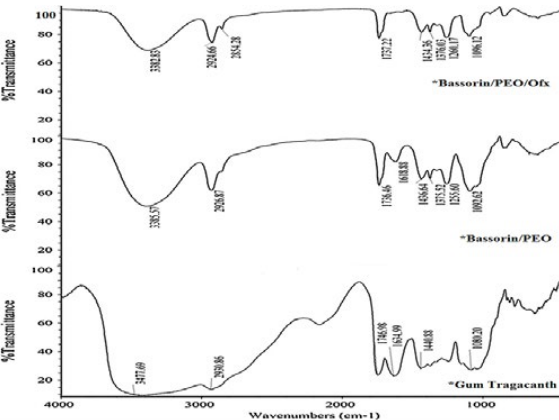
Figure 4: FTIR spectra of Gum Tragacanth, Bassorin/PEO nanofibers and Bassorin/PEO/Ofx nanofibers